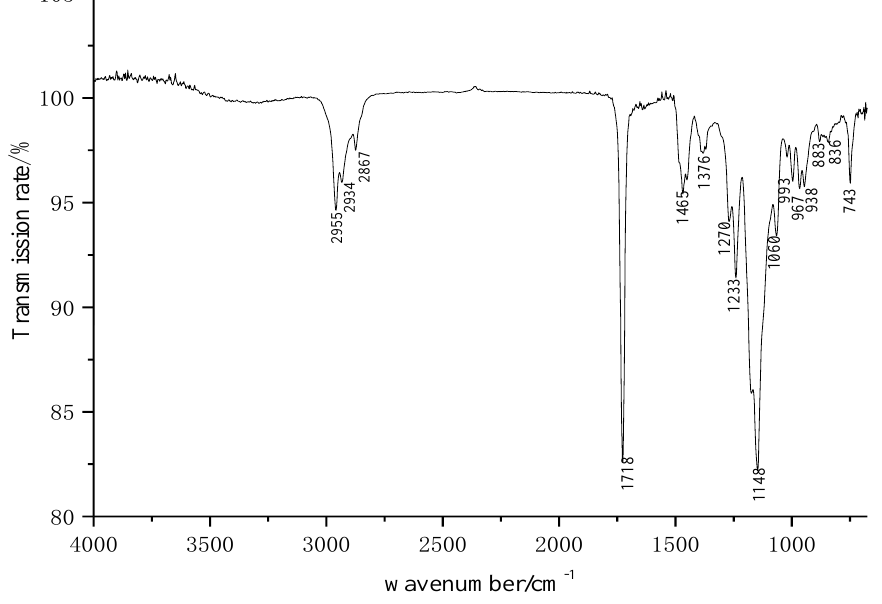
Figure 1. FT-IR analysis of low temperature flower paper.